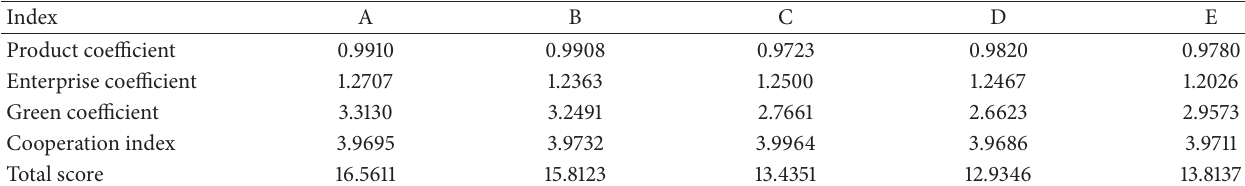
Table 12: Final scores of five